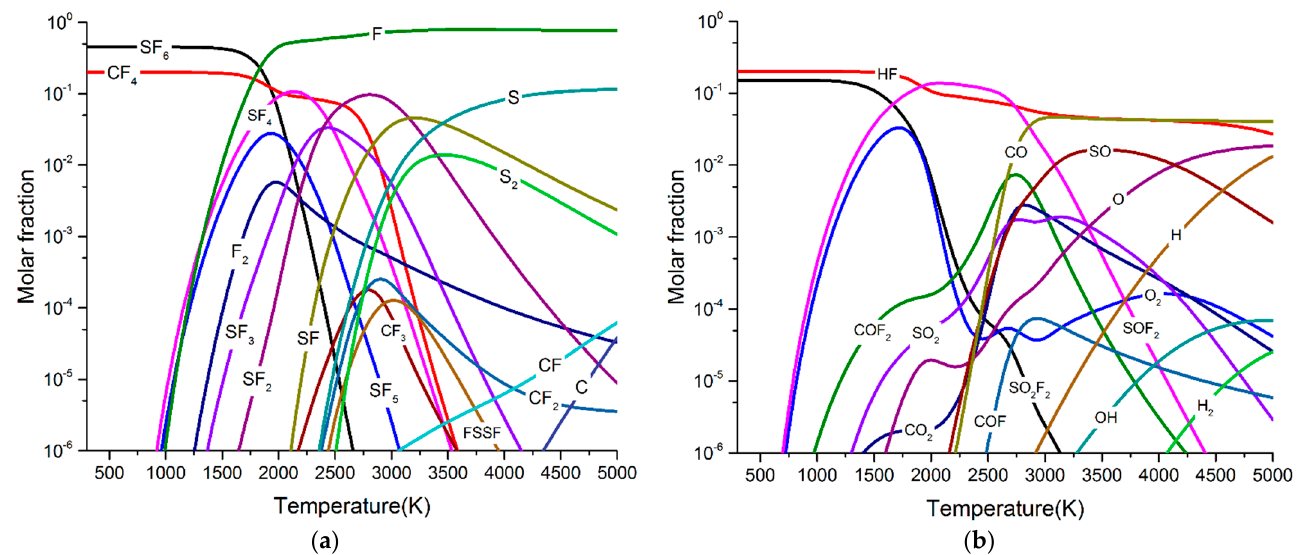
Figure 12. Particle composition of 60% SF 6 + 20% CF 2 + 10% H 2 O + 10%O 2 arc plasma at 0.6 MPa. ( a ) SF 6 , SF 5 , SF 4 , SF 3 , SF 2 , SF, S, S 2 , F, F 2 , FSSF, CF 4 , CF 3 , CF 2 , CF, and C particles. ( b ) SOF 2 , SO 2 F 2 , COF 2 , COF, O 2 , O, SO 2 , SO, CO 2 , CO, HF, H, H 2 , and OH particles.